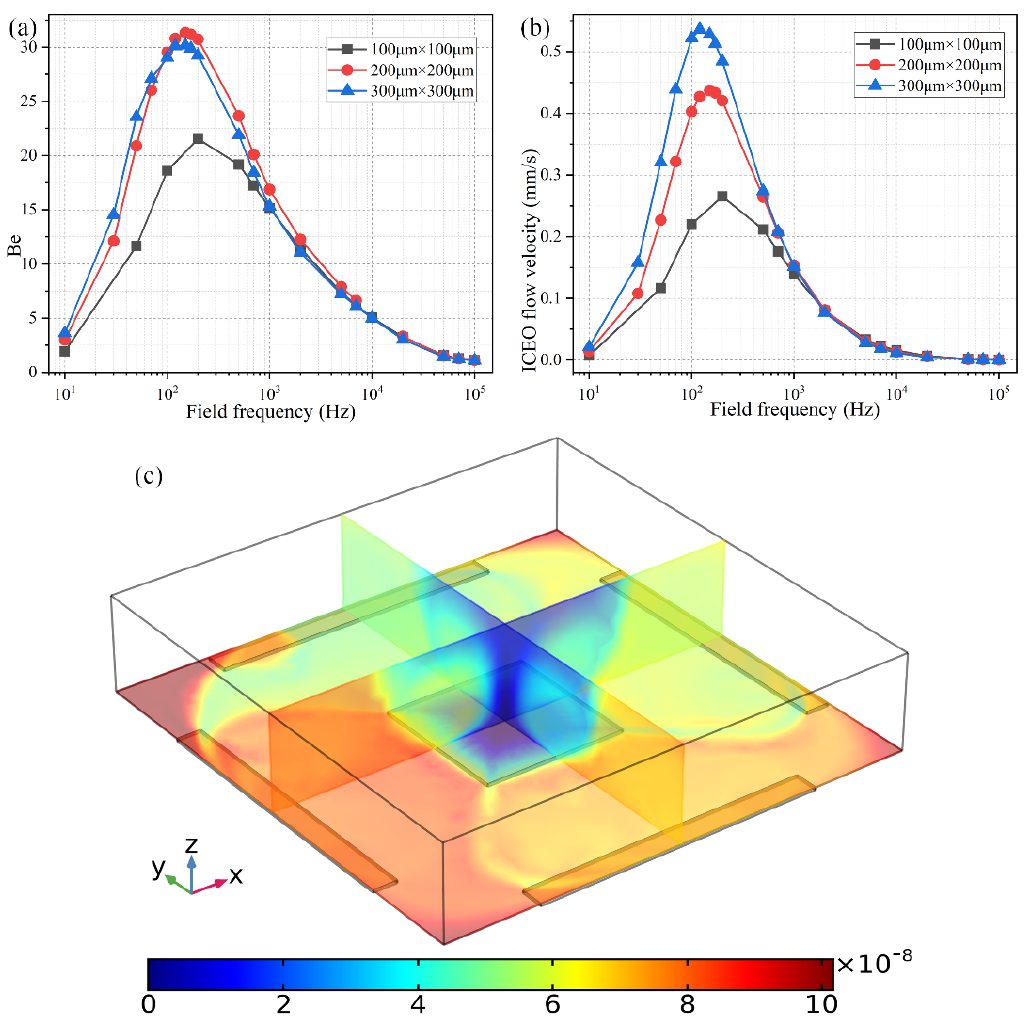
Figure 8. Effect of the FE’s size on the binding reaction improvement at a given voltage amplitude V 0 = 4 V. ( a ) Frequency-dependent Be for different FE’s edge length; ( b ) Frequency-dependent ROT-ICEO slipping velocity when the edge length of the central FE takes the value of 100 μ m, 200 μ m, and 300 μ m, respectively. ( c ) A cross-sectional plot of the suspended antigen concentration on top of a 300 μ m × 300 μ m FE with an AC voltage supply of V 0 = 4 V and f = 150 Hz at t = 100 s.